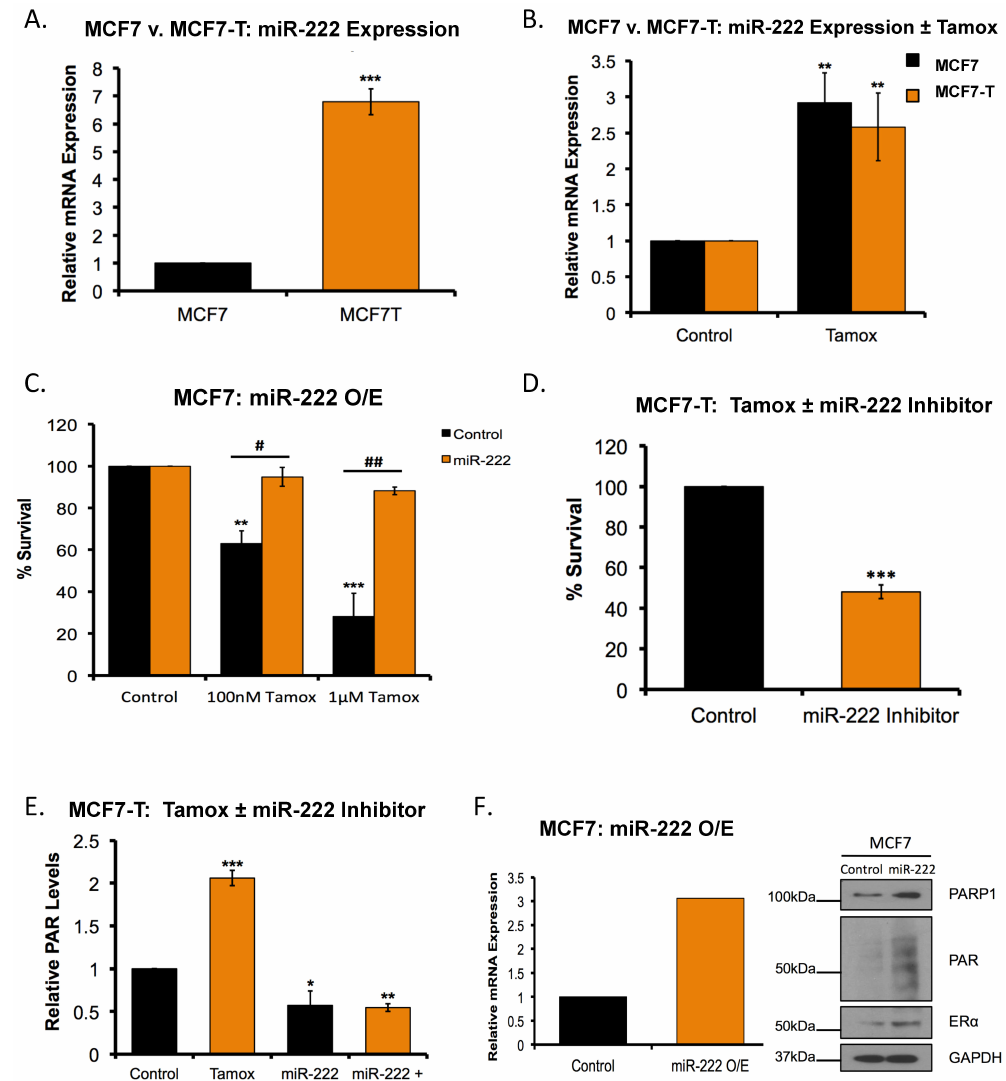
Figure 5. miR-222 mediates ER response to tamoxifen, and tamoxifen-mediated PARP1 activation. ( A ) Basal miR-222 expression was measured in MCF7 and MCF7-T cells by qRT-PCR analysis. ( B ) MCF7 and MCF7T cells were treated for 4 h with 100 nM tamoxifen (Tamox) and miR-222 expression was measured by qRT-PCR analysis. ( C ) MC7 cells were treated with the indicated concentration of Tamox for 4 h, with or without miR-222 overexpression. Treated cells were subjected to colony formation assays. Quantification is representative of three independent experiments. ( D ) MCF7-T cells were treated 72 h with 100 nM Tamox with or without miR-222 inhibition (KD). Treated cells were subjected to colony formation assays. Quantification is representative of three independent experiments. ( E ) MCF7-T cells were treated for 4 h with 100 nM Tamox with or without miR-222 inhibition. Post treatment cells were subjected to PAR ELISA. Quantification is representative of three independent